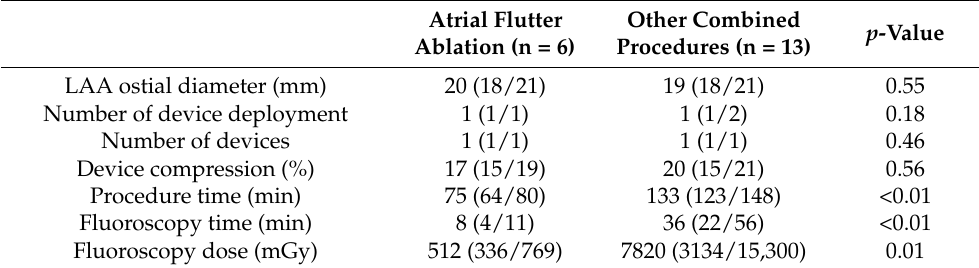
Table 3. Atrial Flutter Ablation